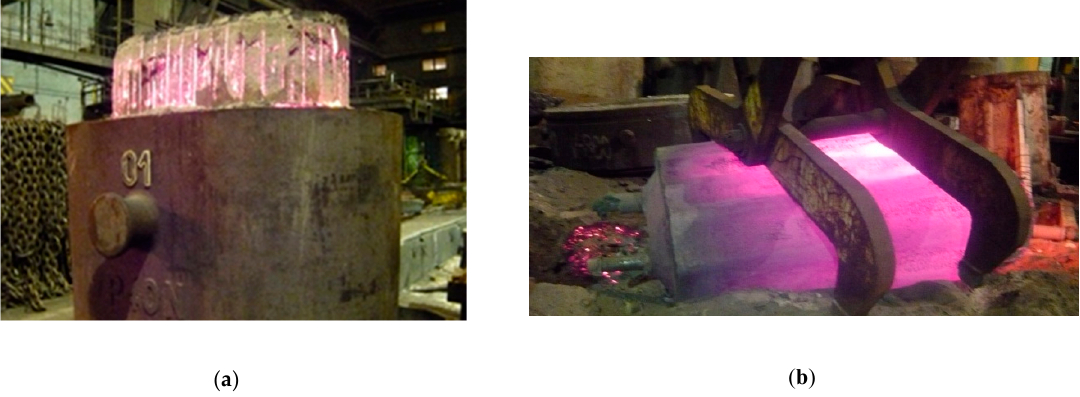
Figure 6. ( a ) Head of stripped slab ingot P40N; ( b ) Slab ingot P40N handling. A plate having dimensions of approximately 1010 mm width × 310 mm depth × 5350 mm length was forged from a P40N ingot on a forging press in two forging operations (forging of tong hold and forging of ingot head into rectangular cross section, forging to required dimensions, see Figure 7a and cutting of ends), and this plate was then divided into two shorter plates, see Figure